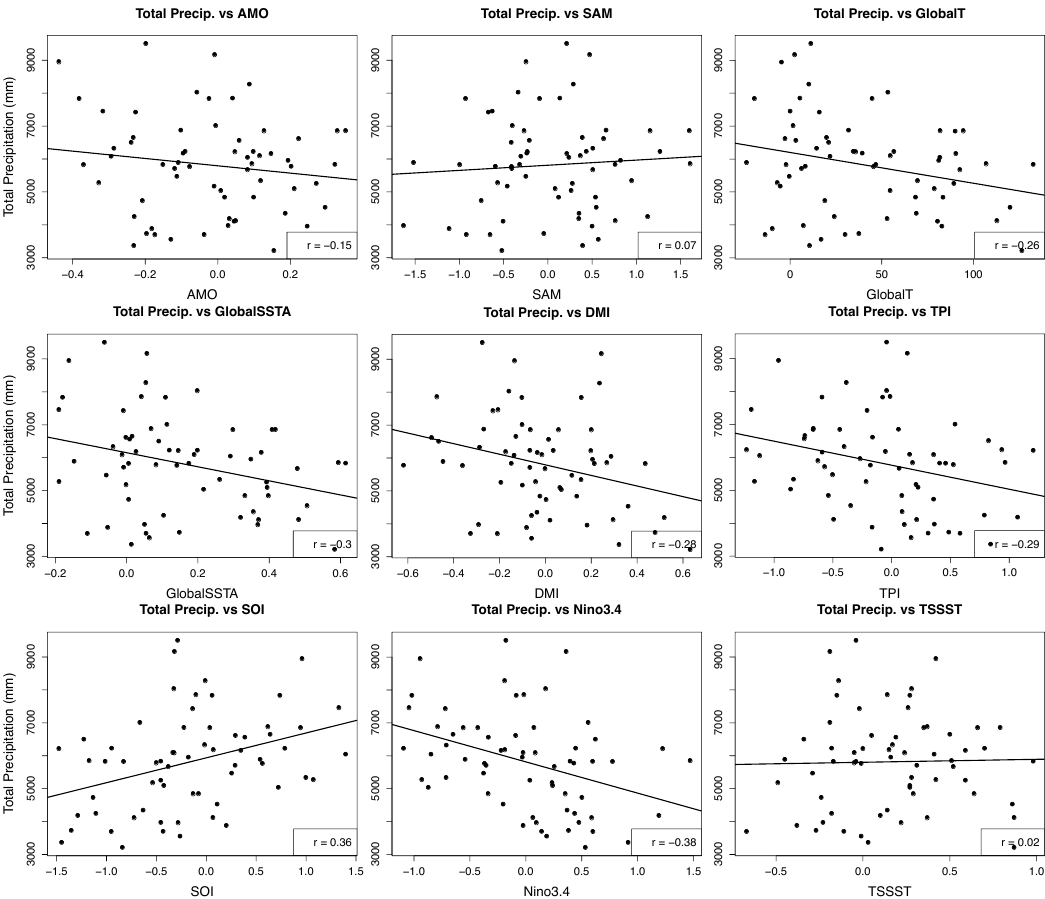
Figure 2. Scatter plot of annual precipitation across the Sydney catchment area (SCA) against each climate driver that serves as a possible attribute. The thin black line shows a linear fit against the data using least squares regression. Correlations of each predictor against precipitation are provided in the box to the lower right of each sub-panel; low correlations ( | r | < 0.3) indicate a weak linear relationship between a predictor and